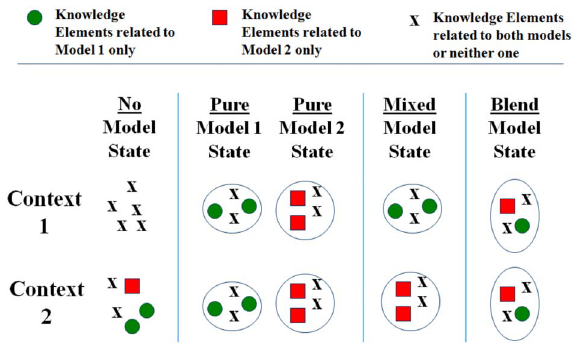
FIG. 3. (cid:1) Color (cid:2) Mental